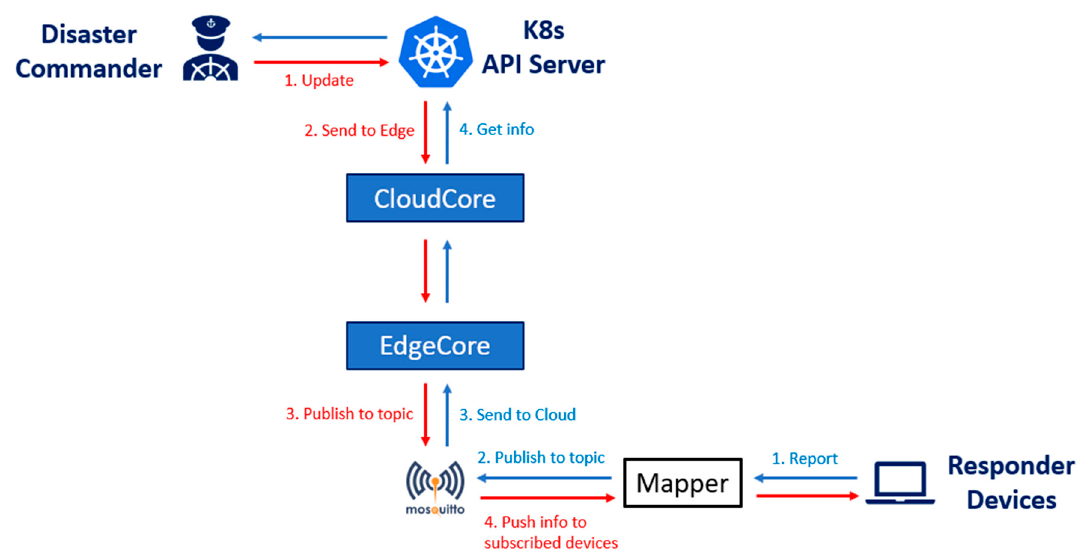
Figure 8. Device Management using KubeEdge.